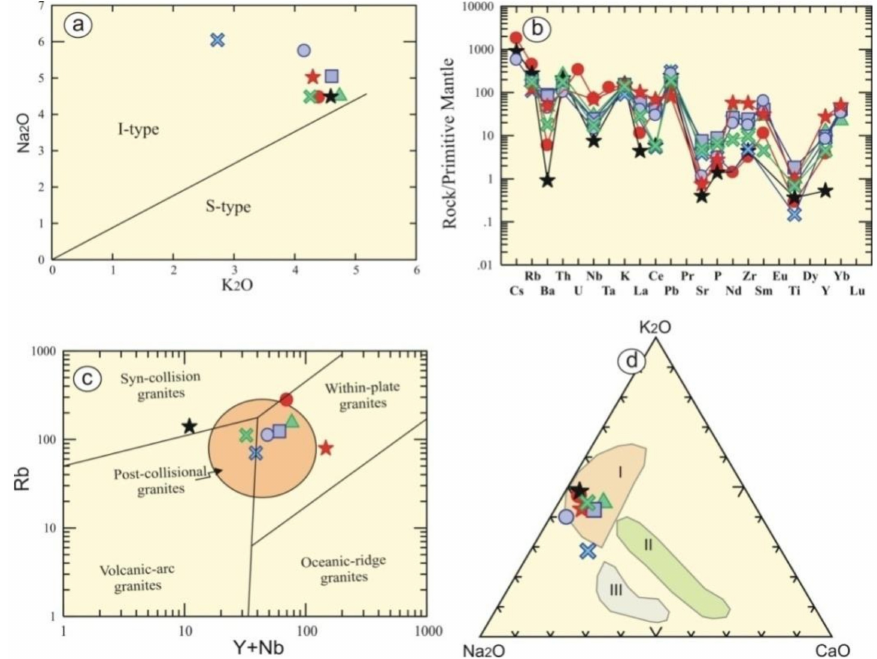
Figure 4. ( a ) K 2 O-Na 2 O binary diagram (Hine et al.) [28]; ( b ) Trace elements pattern normalized to the primitive mantle (Sun and McDonough) [29]. Tectonic discrimination diagrams for ( c ) Rb vs. Y + Nb binary diagram (Pearce et al.) [30], where the post-collisional field is adapted from (Pearce) [31]; and ( d ) Na 2 O-K 2 O-CaO of the Egyptian granitoids (Hassan and Hashad) [32]. I = late (subphase) orogenic calc-alkaline phase, II = early subphase of younger granites, III = older calc-alkaline